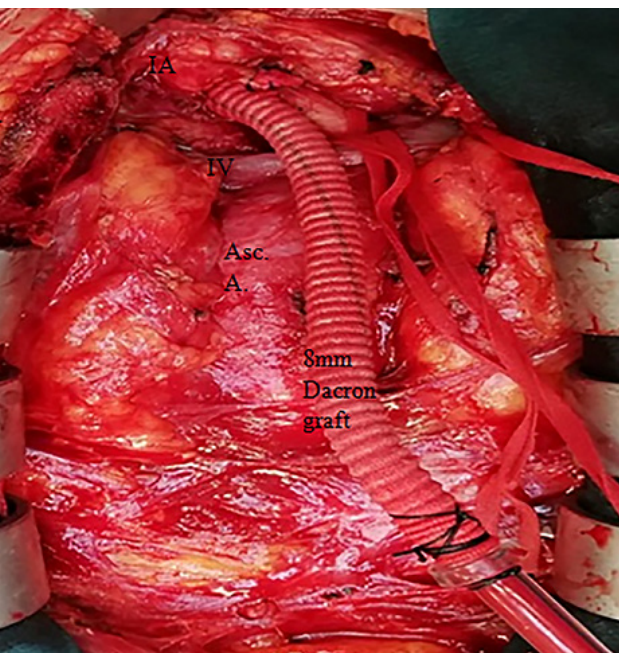
Fig. 1 - Innominate artery (IA) cannulation with 8-mm side-graft method. The graft is anastomosed to the artery in end-to-side fashion and is cannulated with a 24-F arterial cannula. Asc. A.=ascending aorta; IV=innominate